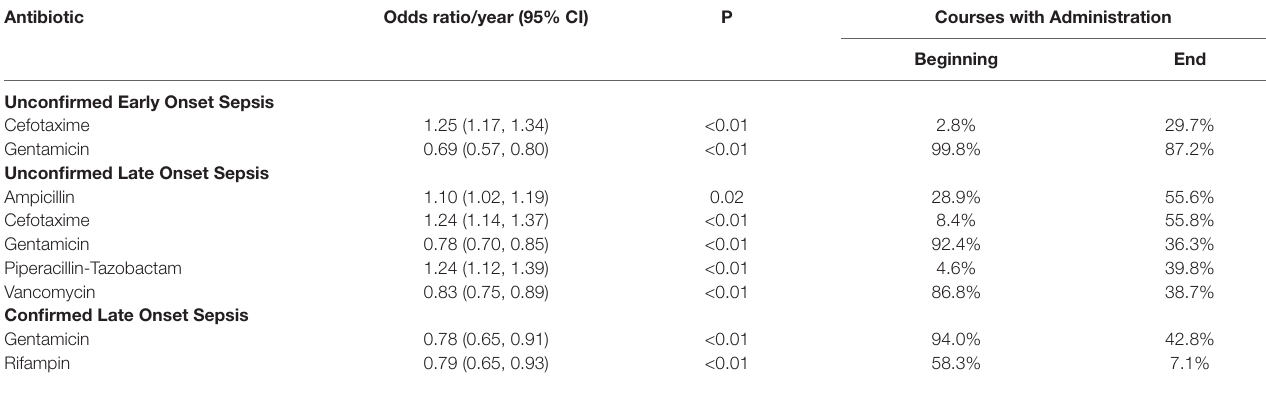
TABLE 4 | Antibiotics with significant changes in administration rates over time. Results of logistic regression modeling with antibiotic administration rates at the beginning and end of the time period (1/1/2006 - 12/31/2017). Antibiotic Odds ratio/year (95% CI) P Courses with Administration